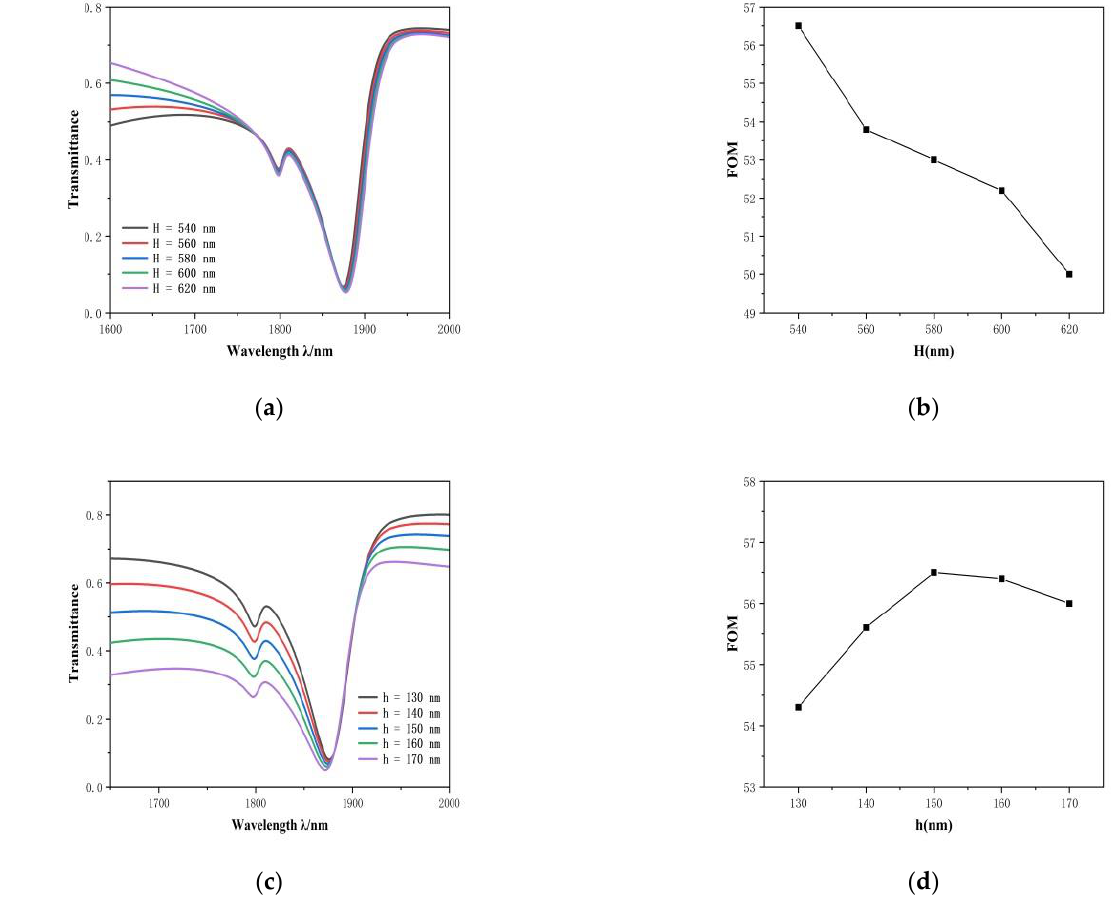
Figure 7. ( a ) Transmission spectra for the different separations H of the twin symmetrical rectangular baffles; ( b ) varying figure of merit (FOM) with increasing separation between the two rectangular baffles; ( c ) transmission spectra for the various heights of the two symmetrical rectangular baffles; and ( d ) varying FOM with increasing height of the two rectangular baffles.